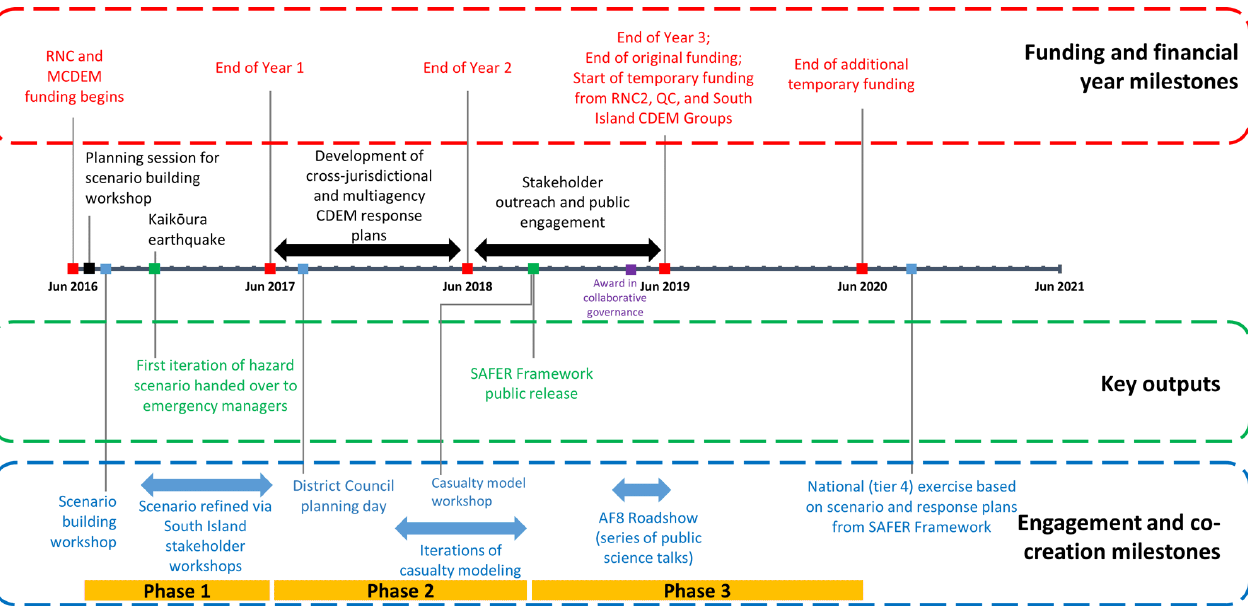
Fig. 1 . Detailed time line of major Project AF8 milestones, including key moments of the funding cycle, main generated outputs, and